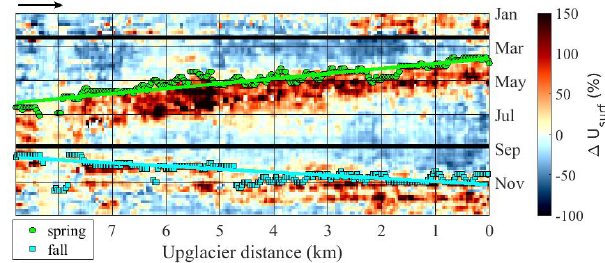
Figure 5. Illustration of our automatic picking of the onset of the spring/summer and autumn accelerations. The background is the annual pattern of relative changes in glacier velocity with respect to the annual median velocity along the flowline of the Malyy Tany- mas Glacier (as in Fig. 4j). Round dots and squares show the auto- matically picked onset of the spring/summer and autumn accelera- tions, respectively. Green and light blue lines show the linear fits of the migration of accelerations as a function of along-flow distance. The black lines show the temporal limits to define the spring/sum- mer and autumn